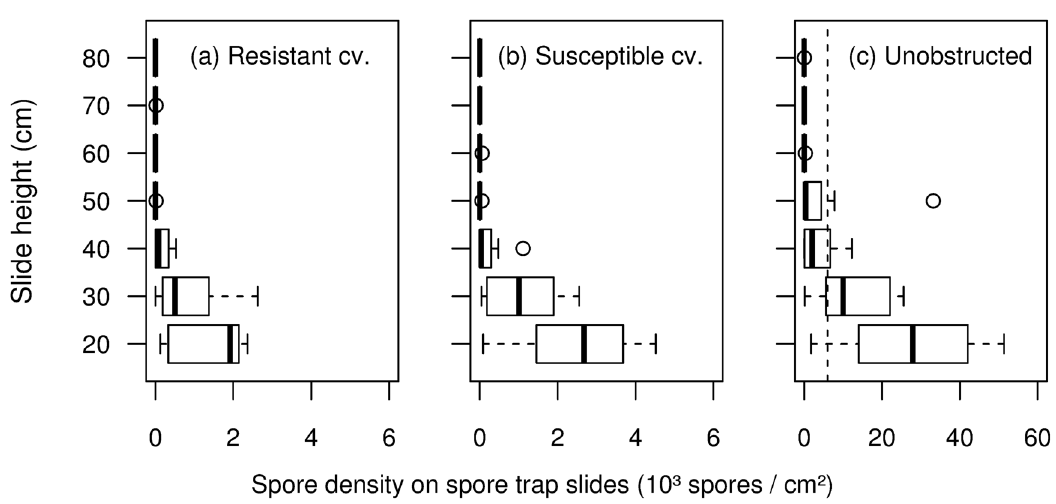
Fig 4. Spore flux as a function of canopy height (spores / cm 2 of spore trap slide). Spore fluxes were measured17 cm from the inoculumsource for resistant (a) and susceptible(b) cultivar differing by their canopy architecture and in an unobstructed space (c). The vertical dashedline on graph c indicatesa spore density of 6 × 10 3 spores per cm 2 , which is the maximum value for graphs (a) and (b). On each graph, each heightcorrespondsto a total of 8 slides of spore traps (2 slides per canopy x 2 rain types x 2 repetitions). Distributions at 20 and 30 cm height differed significantly between(a) and (b) accordingto the χ 2 test of independence.